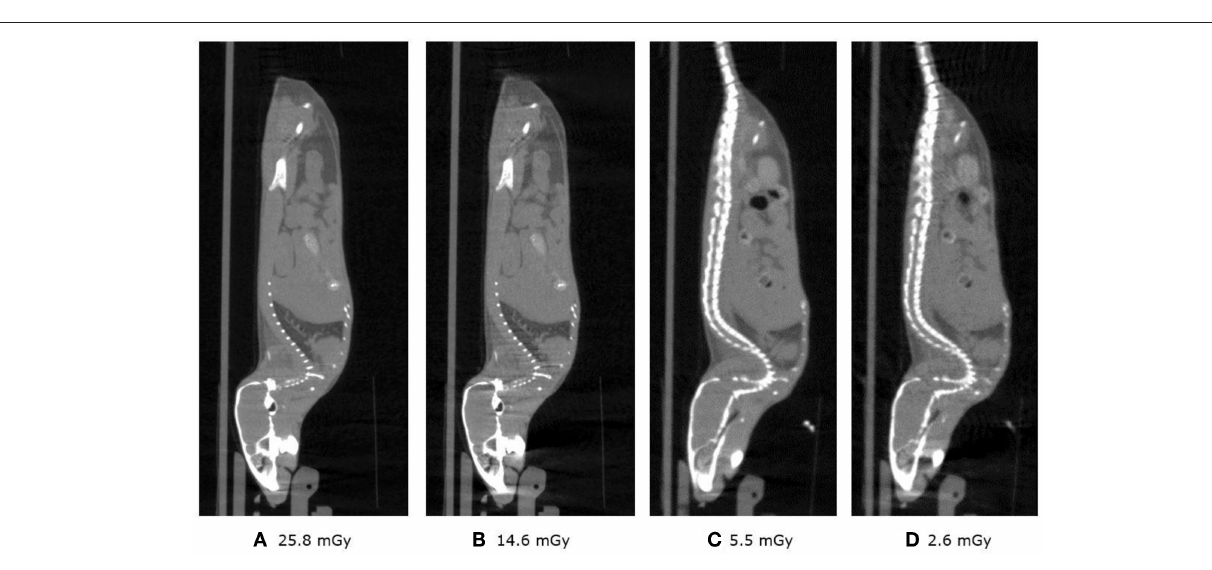
low-dose CT system, dose and throughput benefits can be further